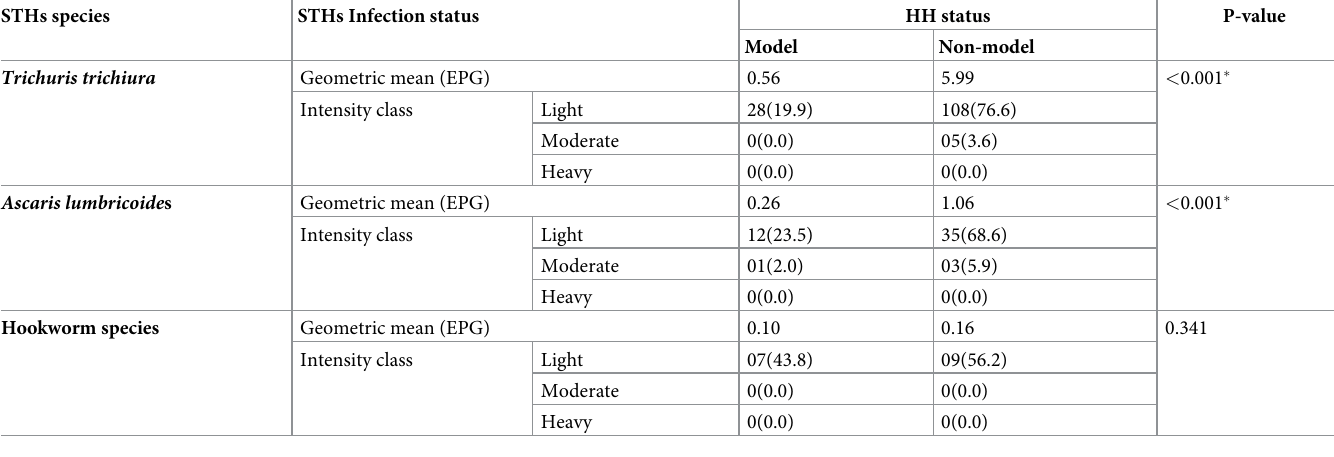
Table 2. Infection intensity thresholds of STHs with the HH training status of selected districts of Seka Chekorsa woreda, Jimma zone, Southwest Ethiopia. STHs